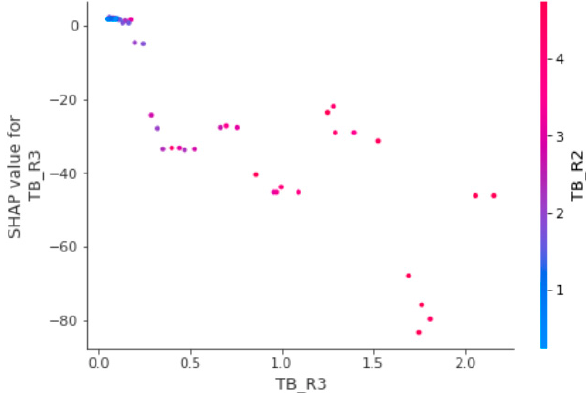
Figure 10. SHAP dependence plot of the input variables.